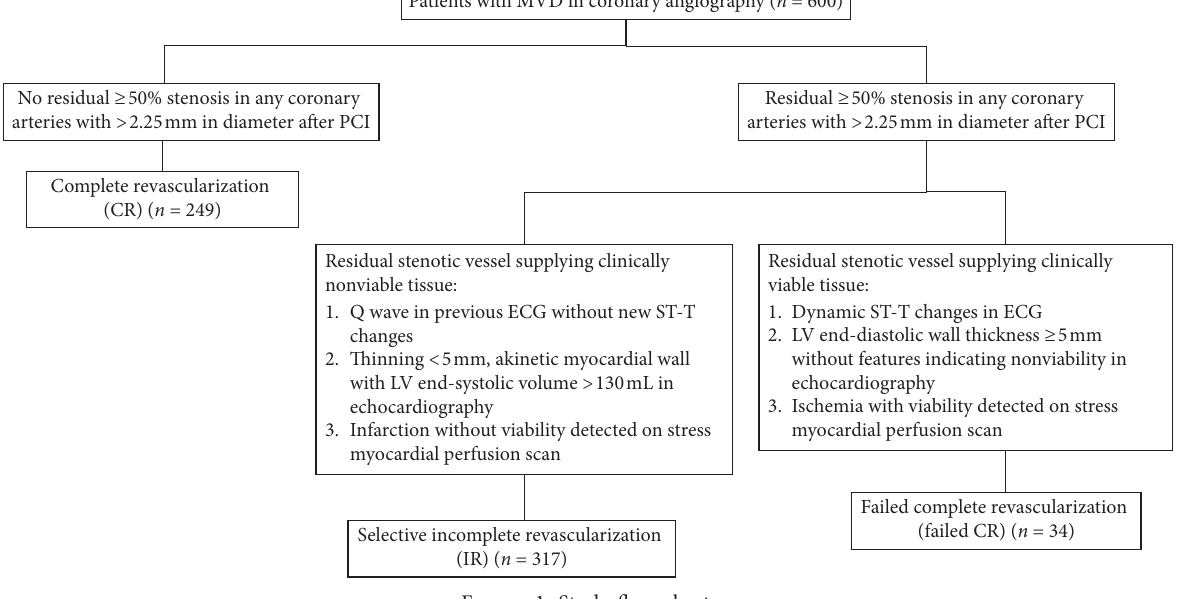
Figure 1: Study flow